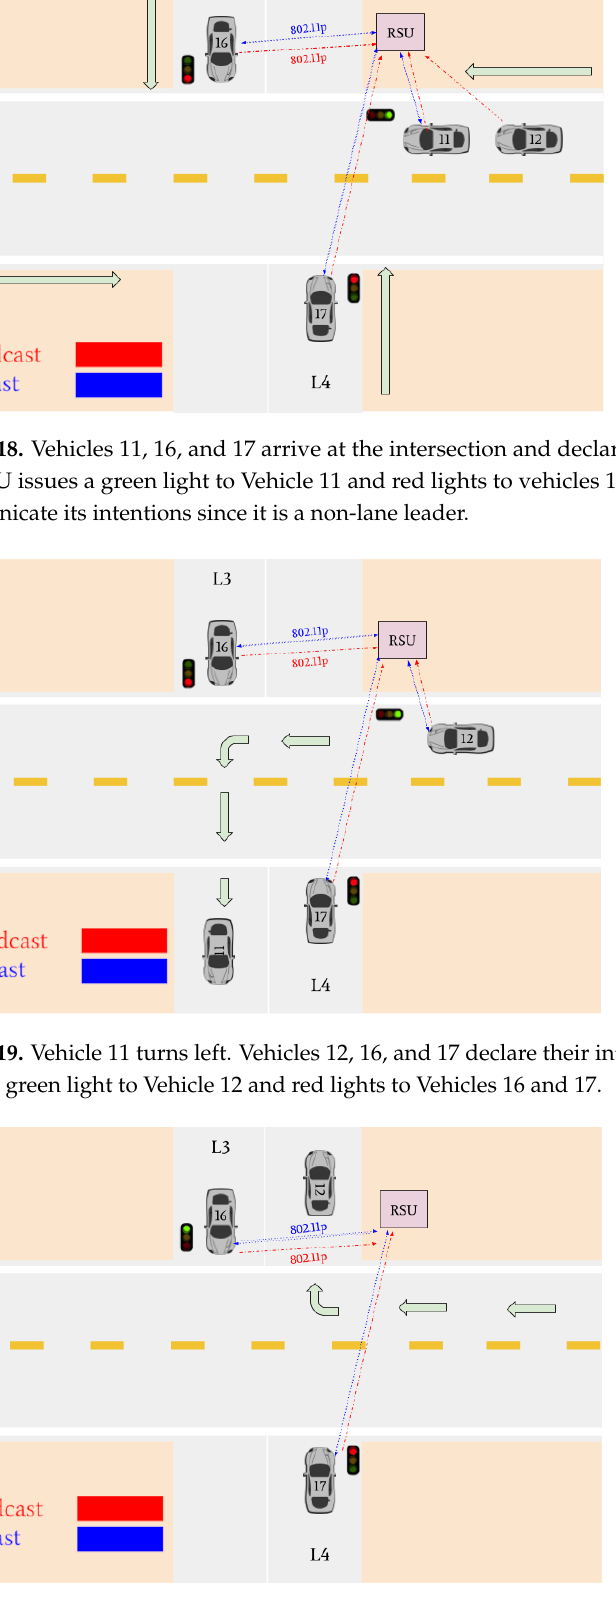
Figure 20. Vehicle 12 turns right. Vehicle 17 and Vehicle 16 declare their intention to the RSU. The RSU issues a green light to Vehicle 16 and a red light to Vehicle